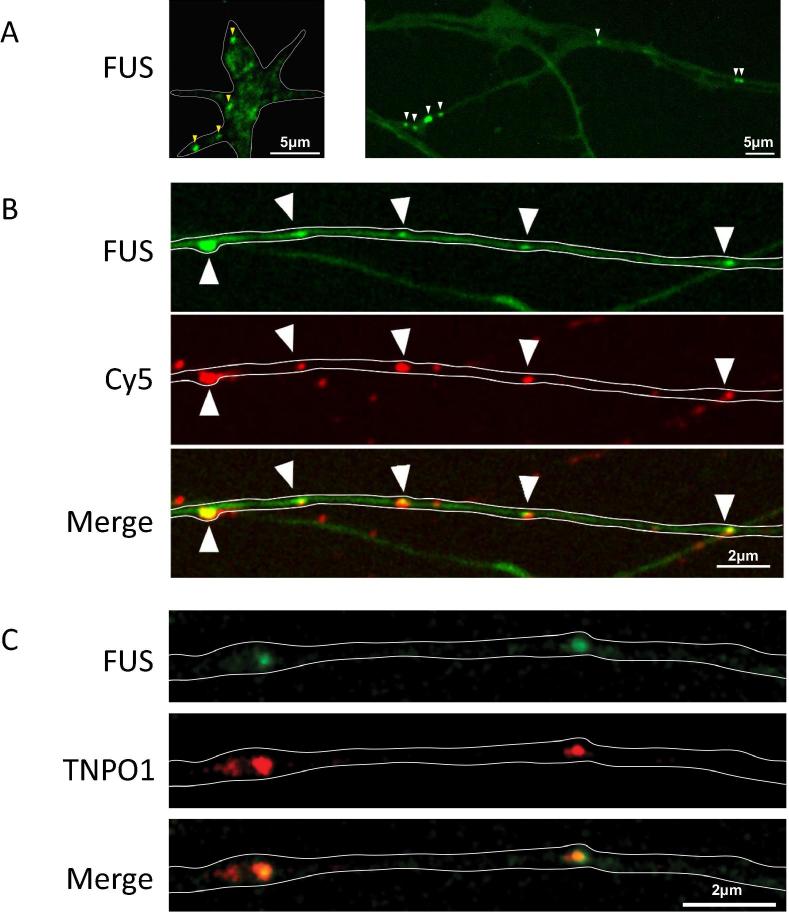
A. FUS RNP granules are detectable in axon terminals and axons using GFP labelled anti-FUS antibody is (arrowheads). B. FUS RNP granules in axon terminals colocalise with markers of RNA (Cy5). C. FUS and TNPO1 colocalise in axons and axon terminals expressing endogenous FUS and Cherry tagged TNPO1. Adapted from Murakami et al., neuron 88: 678, 2015 and Qamar et al. Cell, in press, 2018.